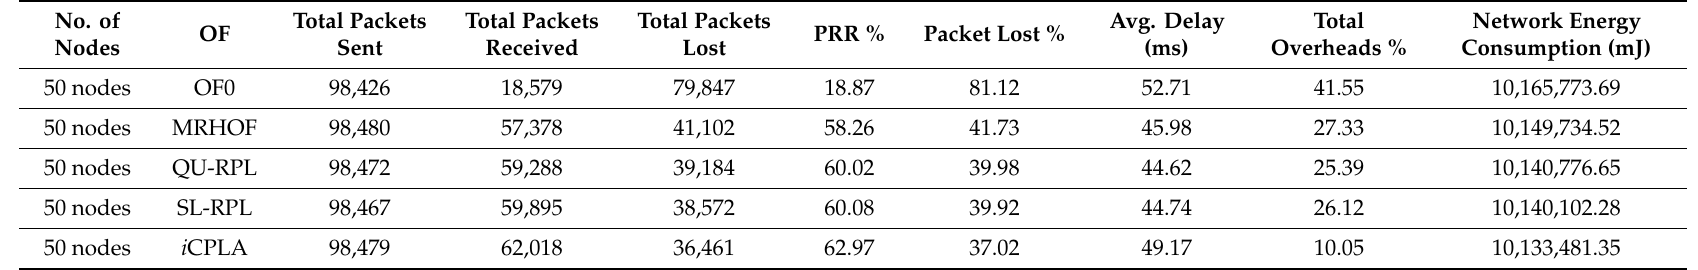
Table 3. Analysis of grid topology with varying heterogeneous tra ffi c